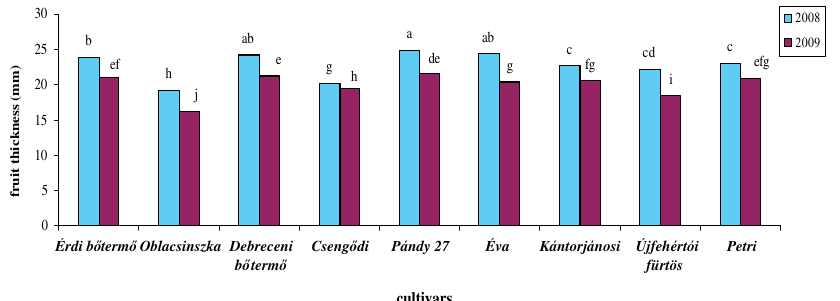
Figure 3. Fruit thickness of the studied sour cherry cultivars in tow years (2008 & 2009). Different letters indicate significant differences between treatments (P